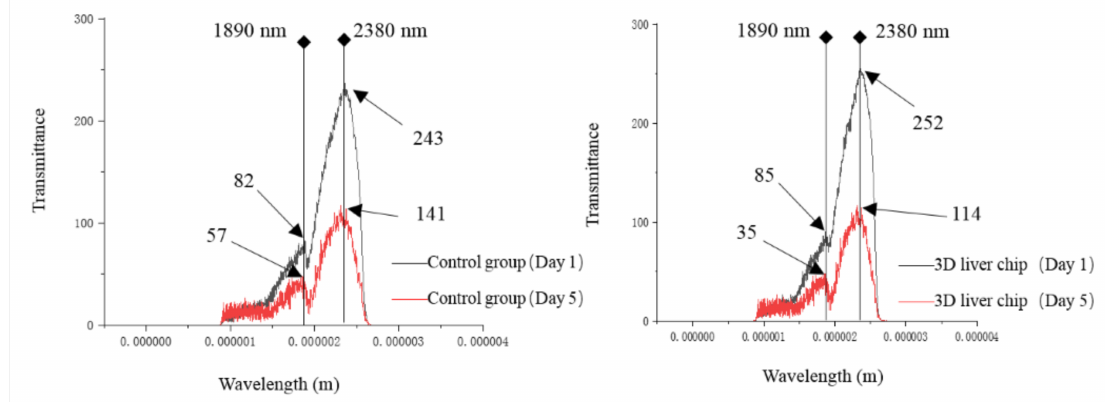
Figure 6. Results of near-infrared